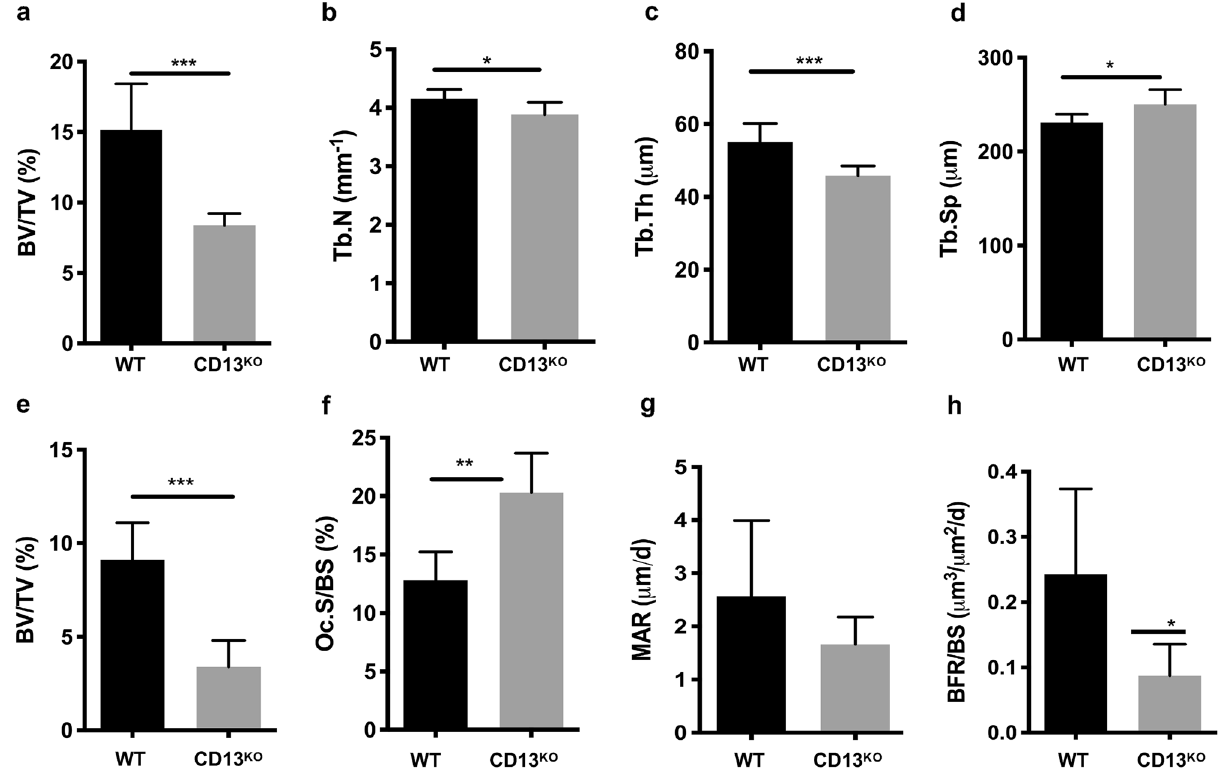
Figure 2. CD13 deficiency leads to marked reduction in trabecular bone volume and structure in 18–25 week old aged mice. ( a – d ) Bone morphometry by µCT analysis; ( a ), BV/TV(%); Bone volume/Tissue volume ( b ), Trabecular number, ( c ) Trabecular Thickness ( d ) Trabecular Separation. ( e–h ) Histomorphometric analysis ( e ), BV/TV(%), ( f ) Oc.S/BS; % OCs per bone surface, ( g ) Mineral apposition rate (MAR), ( h ) Bone formation rate (BFR/BS) measured by Osteomeasure software (OsteoMetrics, Decatur, USA) (https:// www. osteo metri cs. com). All samples were scanned, reconstructed, and analyzed in a Scanco µCT40 running Evaluation Program V6.6 (http:// www. scanco. ch/ en/ syste ms- solut ions/ softw are. html). Data represents ± SD. (N = 6; WT and N = 7; CD13 KO . * **p < 0.001, * *p < 0.01, * p < genitors in CD13 KO mice were similar to wildtype animals 12 . Cells that can generate bone-resorbing osteoclasts reside in both BM and peripheral hematopoietic organs 24 . To determine if differences in osteoclast progenitor (OCP) frequency are responsible for the loss of bone mass in the absence of CD13, we analyzed the distribu- tion of primary OCP in both the BM microenvironment and spleen in WT and CD13 KO mice. Flow cytometric analysis (Supplementary Fig. S4) revealed that the OCP profile indicated by CD3 − , B220 − , NK1.1 − , CD11b −/lo , CD115 + , CD117 + in the BM (a, WT vs. CD13 KO ; 1.7 vs. 1.95) and CD3 - , B220 - , NK1.1 - , CD11b + , Ly6G - , Ly6C + , CD115 + in spleen (b, WT vs. CD13 KO ; 0.24 vs. 0.238) 24 and common myeloid progenitor population indicated by lin − c-kit + Sca-1 − CD34 + in the BM ( c , WT vs. CD13 KO ; 0.99 vs. 0.88) is similar between genotypes, indicating that the absence of CD13 does not change the intrinsic differentiation potential of myeloid cells to osteoclast progenitors. Osteoclast-like cell formation is enhanced in U937 cells expressing CD13 CRISPR. To confirm that the effect of loss of CD13 in cell fusion extends across species, we utilized human U937 myeloid cells engi- neered to delete CD13 or express scrambled wildtype control by CRISPR-based technology (Fig. 5f). Differentia- tion of U937 cells with PMA 25–27 for 3 days led to formation of equivalent levels of adherent monocytic cells in both genotypes (data not shown). Subsequent stimulation with human recombinant M-CSF and RANKL led to the aggregation of monocyte-like cells followed by differentiation into large multinucleated TRAP + osteoclast- like cells over time (8-10d) which was significantly accelerated in cells lacking CD13 compared to scrambled controls (Fig. 5a–c). TRAP+, multinucleated CD13 KO CRISPR cells exhibited increased resorptive activity when grown in Osteo assay plates for 17 days as indicated by the relative resorption area (Fig. 5d,e), confirming that the cells generated from U937 are indeed functional osteoclasts and that CD13 is a negative regulator of cell–cell fusion in both mouse primary cells (BM and periphery) and a human monocytic cell line.